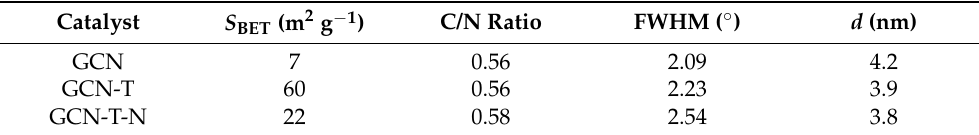
Table 1. The atomic ratio between carbon and nitrogen, specific surface area ( S BET ), XRD peak (002) width at half height (FWHM), and crystallite size ( d ) of the synthesized catalysts. Catalyst